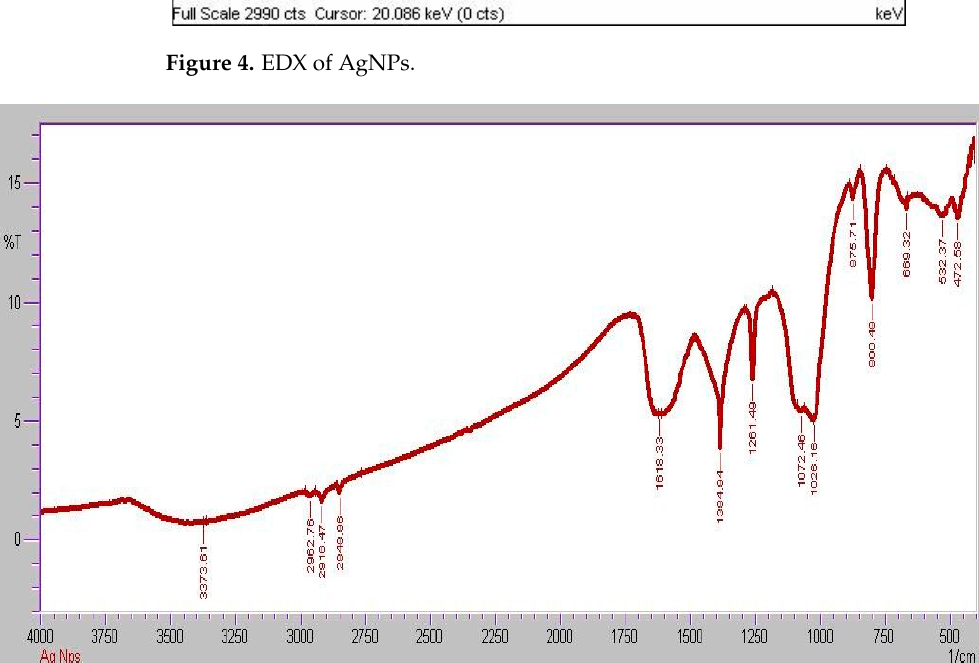
Figure 5. FTIR of AgNPs.